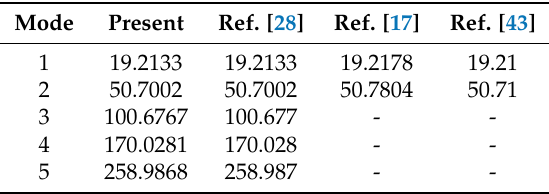
Table 1. The first five non-dimensional natural frequencies of a local Euler–Bernouilli beam resting on a Winkler–Pasternak foundation for the simple-simple boundary condition ( η = 0, δ = 0, K = 25, K p = 25 )